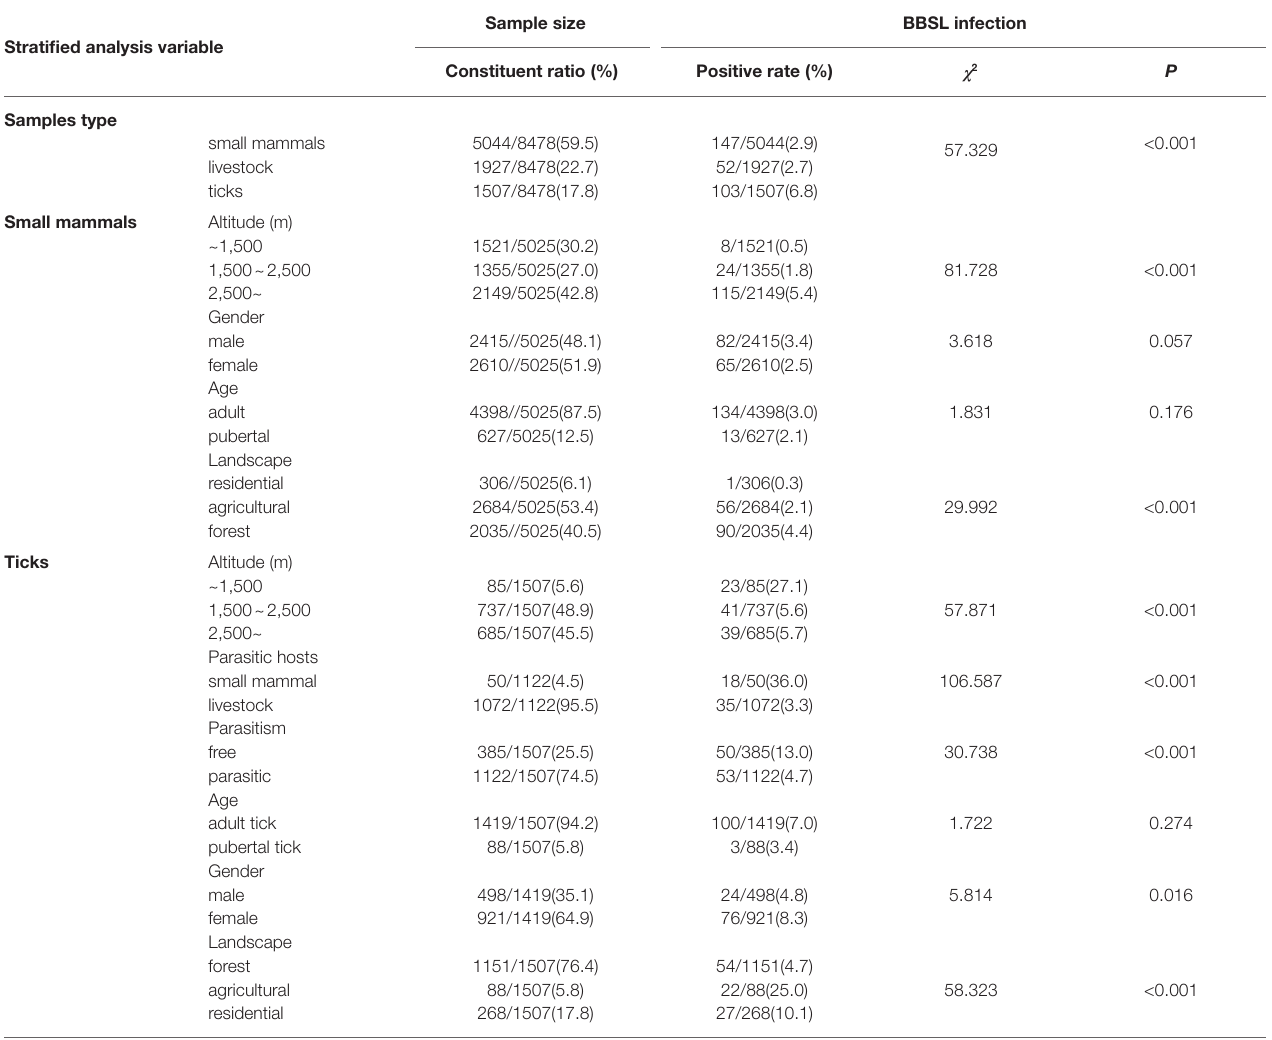
TABLE 4 | Risk factors related to Borrelia burgdorferi sensu lato based on univariate